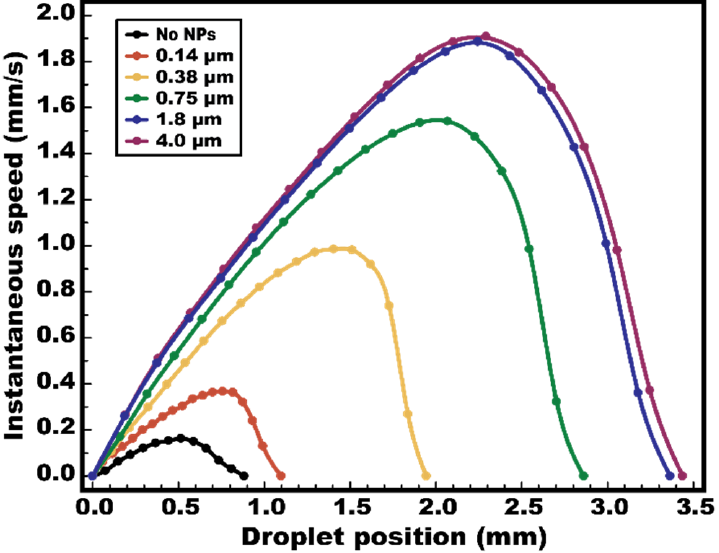
Figure 7. Experimental results of optical DEP actuation. FEOET devices were prepared with various thicknesses of a nanoparticle layer from 0 to 4.0 µm. The moving speeds of a 1.5 µL de-ionized water droplet were measured and recorded at its corresponding positions while a laser beam was illuminated near one edge of the droplet. With no nanoparticles, the droplet’s moving speed reached a peak of 0.163 mm/s. However, by using a 4.0 µm nanoparticle layer on a device, a maximum speed of 1.90 mm/s (>11-fold improvement) was achieved.